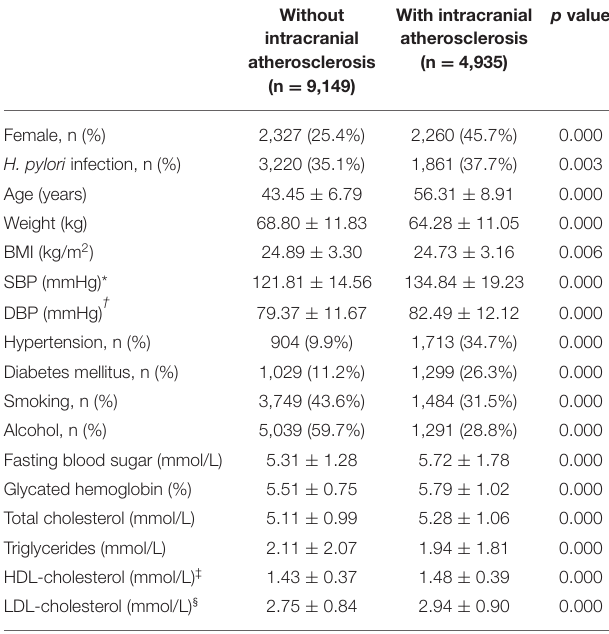
TABLE 1 | Baseline characteristics for patients with and without intracranial atherosclerosis.